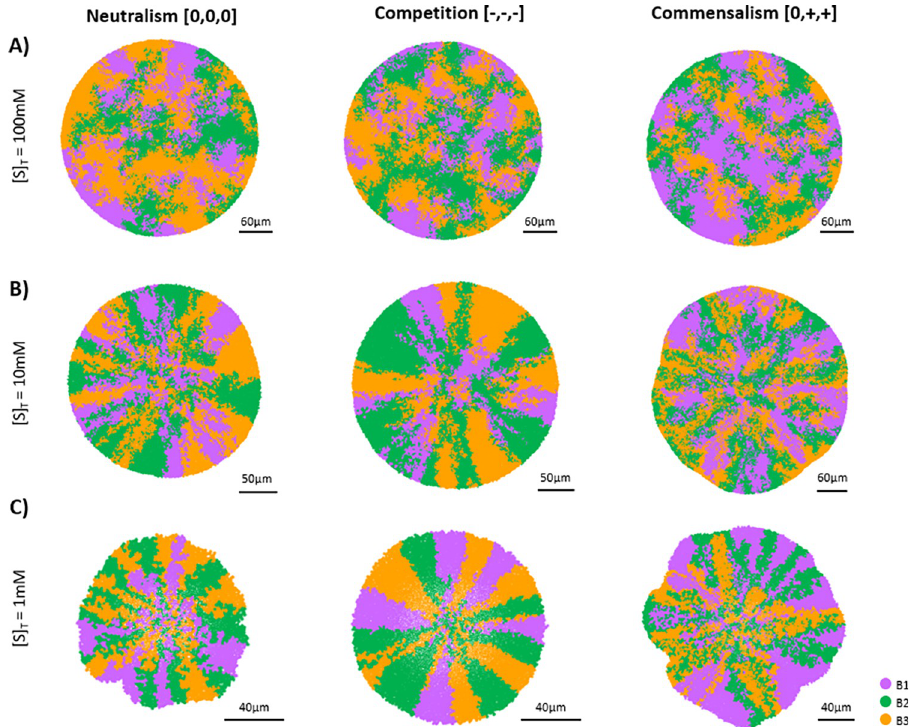
Fig 2. Spatial distribution of microbial populations at different substrates concentrations. (A) Aggregate pictures captured after 8 d of simulation considering neutralism, competition and commensalism with [S] T = 100 mM. (B) Aggregate pictures captured at 10 d of simulation considering neutralism, competition and commensalism with [S] T = 10 mM. (C) Aggregate pictures captured at 15 d of simulation considering neutralism, competition and commensalism with [S] T = 1 mM. None of the simulations are in steady state yet. Black solid line on bottom-right of aggregates represent the scale bar. Substrate profiles on the transverse plane of aggregates have been included on S2 Fig.